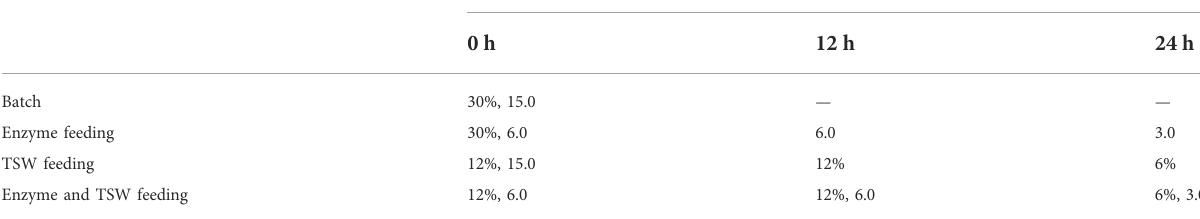
TABLE 2 Enzyme and TSW loadings for different feeding strategies in fed-batch SSCF with a feeding period of 24 h. Samples